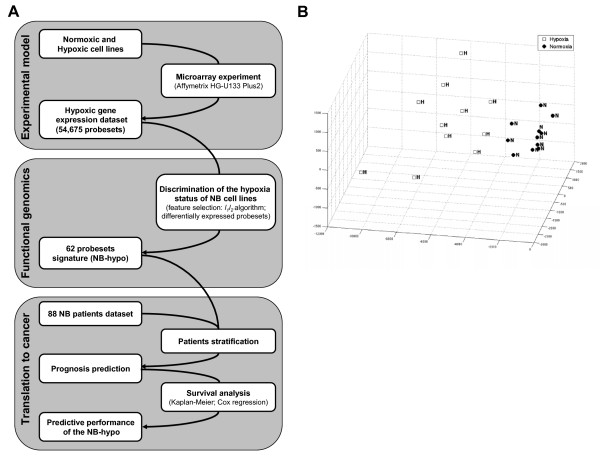
Definition of neuroblastoma hypoxia signature (NB-hypo). A, workflow of the biology-driven approach applied to define the hypoxia signature. The workflow is divided into three main blocks representing, from top to bottom, the experimental data collection, the functional genomics data analysis, and the evaluation of the NB-hypo as prognostic factor in neuroblastoma patients. B, principal components representation of the multivariate analysis performed on the 11 cell lines by l1 - l2 algorithm. This figure illustrates a 3-dimensional visualization of the dataset restricted to the selected probesets projected on their 3 principal components. Open squares (H) represent the cell lines in hypoxic status and the black circles (N) the corresponding cell lines in normoxic status.